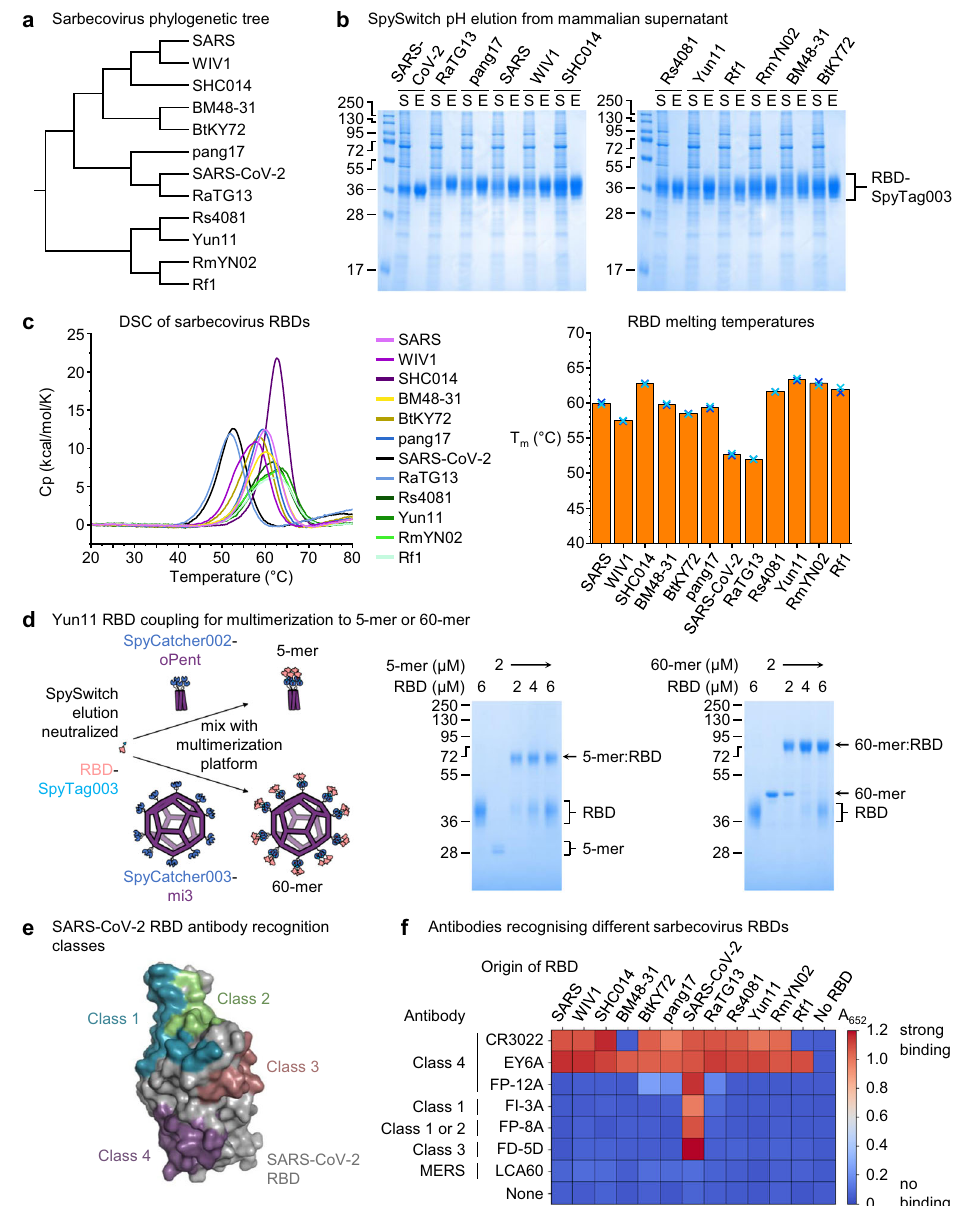
Fig. 5 SpySwitch application to a panel of sarbecovirus RBDs. a Phylogenetic tree of sarbecovirus RBD constructs. b Puri fi cation of sarbecovirus RBDs with a C-terminal SpyTag003 using elution by pH 5.0 at 4 °C, assessed by reducing SDS-PAGE/Coomassie. S is supernatant from Expi293F cells and E is the SpySwitch elution. c Differential scanning calorimetry of sarbecovirus RBD constructs in PBS pH 7.4. On the right, the melting temperature (T m ) is plotted for each construct, with the bars in orange representing the mean and the individual values plotted as blue crosses ( n = 2). d Coupling of Yun11 RBD-SpyTag003 to a 5-mer or 60-mer at the indicated concentrations for 16 h at 4 °C in neutralized SpySwitch elution buffer, before reducing SDS-PAGE/ Coomassie. e SARS-CoV-2 RBD shown with antibody recognition sites class 1 (blue), 2 (green), 3 (bronze) and 4 (purple). f Recognition of sarbecovirus RBDs by a panel of antibodies, with mean absorbance at A 652 from ELISA plotted as a heat map ( n = 3). Blue represents no binding, while red represents strong binding. Molecular weight markers represent kDa. Source data are provided as a Source data fi